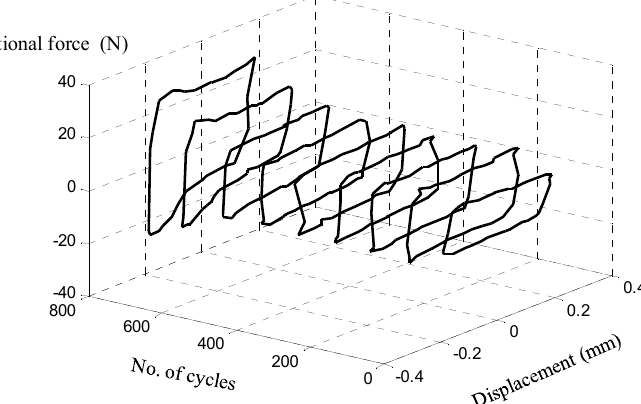
Figure 3. Fretting loops of an electro ‐ deposited coating at a normal force of 49 N, an imposed displacement amplitude of 0.2 mm, and a frequency of 1 Hz.